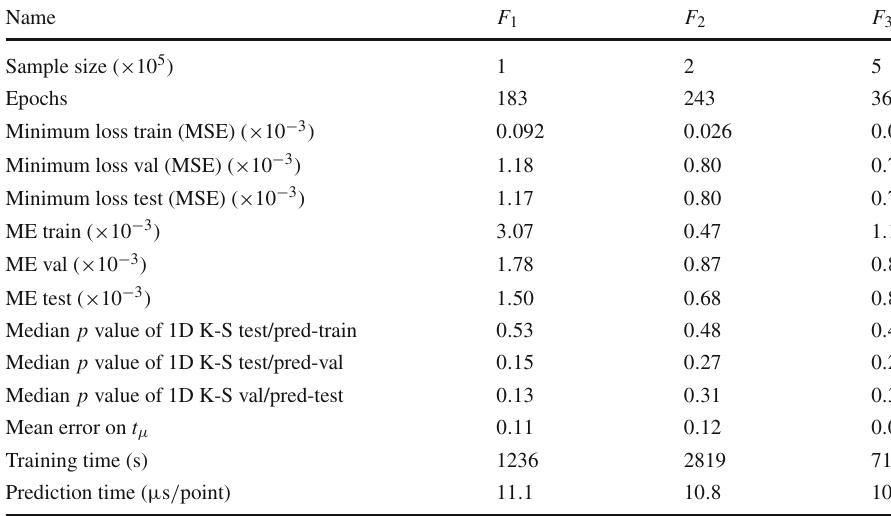
Table 4 Results for the best models (Full DNNLikelihood) for different training sample size. All models have been trained for 5 times to check the stability of the result and the best performing has been quoted. Prediction time is evaluated on a test set with half the size of the training set using the same batch size used in training, and evaluating on a Nvidia Tesla V100 GPU with 32GB of RAM. All best models have d HL = 5 × 10